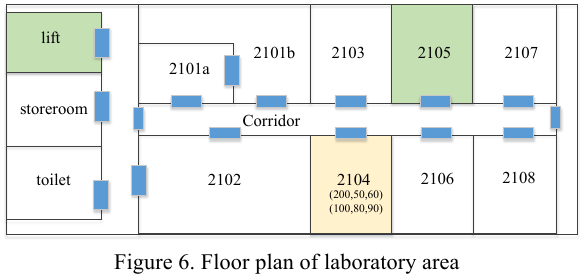
Figure 6. Floor plan of laboratory